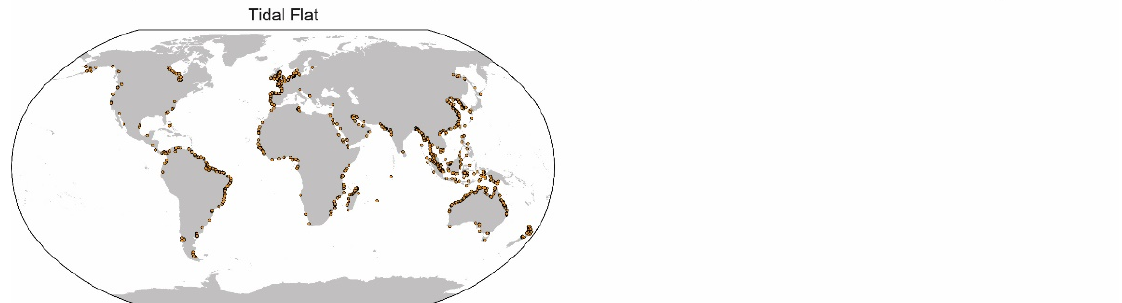
Figure 1. The global distribution of the five major coastal ecosystem occurrence records included in the coastTrain training library. Records for other cover types (‘permanent water’ and ‘terrestrial other’; n = 13,260) are not shown on this figure. Records for ecosystems that are still under development and are likely to be considerably expanded in future versions, including kelp forests (n = 12 records) and rocky shores (n = 56 records), are not shown. Note the majority of mapping programs did not collect occurrence records above 60°N.